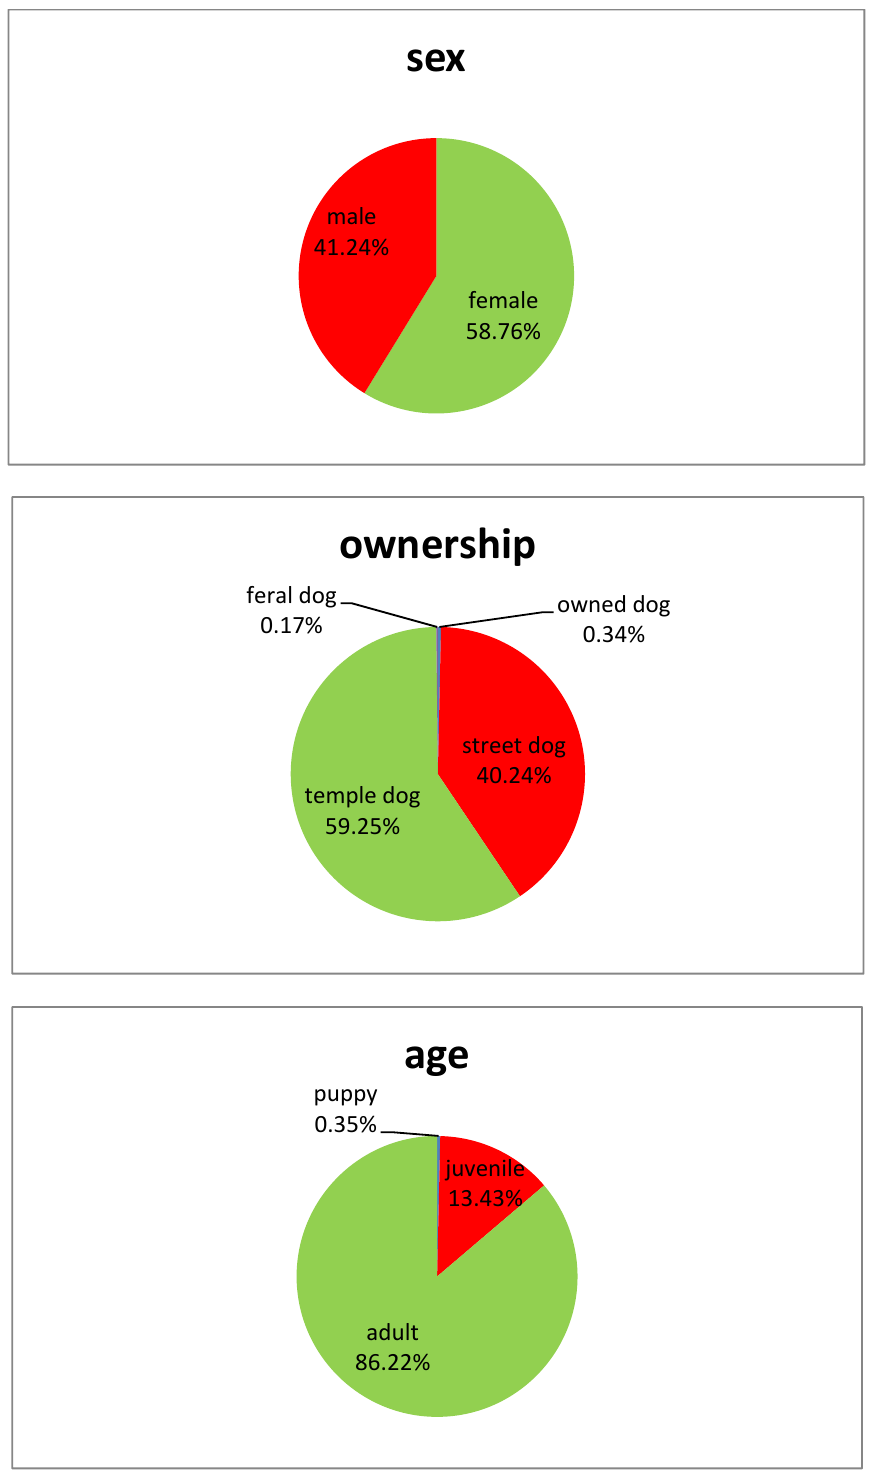
Figure 2. Characteristics of the dog population included in this study.